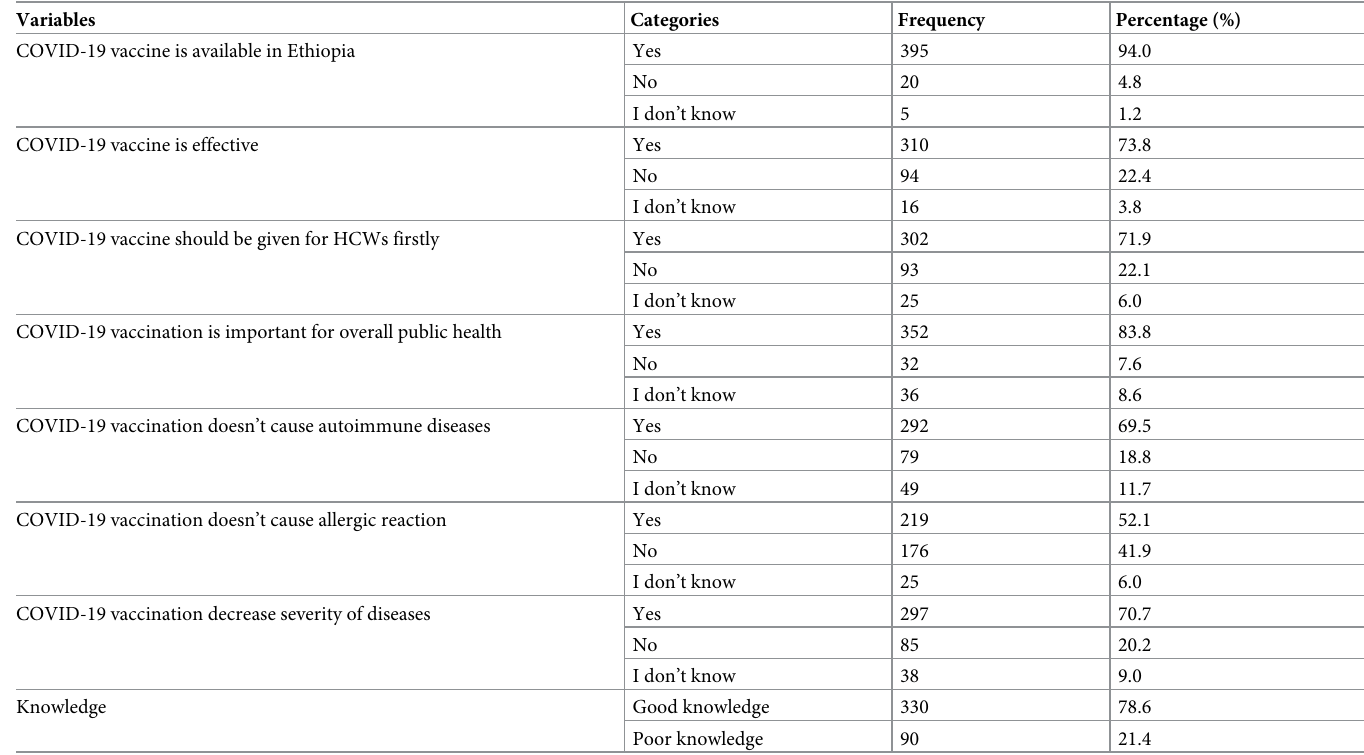
Table 2. Knowledge about COVID-19 vaccine among medical and health science students attending Wolkite University, Ethiopia, 2021 (n =